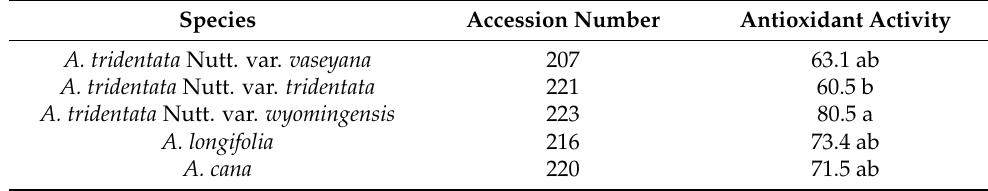
Table 8. Mean antioxidant activity ( µ M Trolox equivalents/g) of the essential oils from the five species.